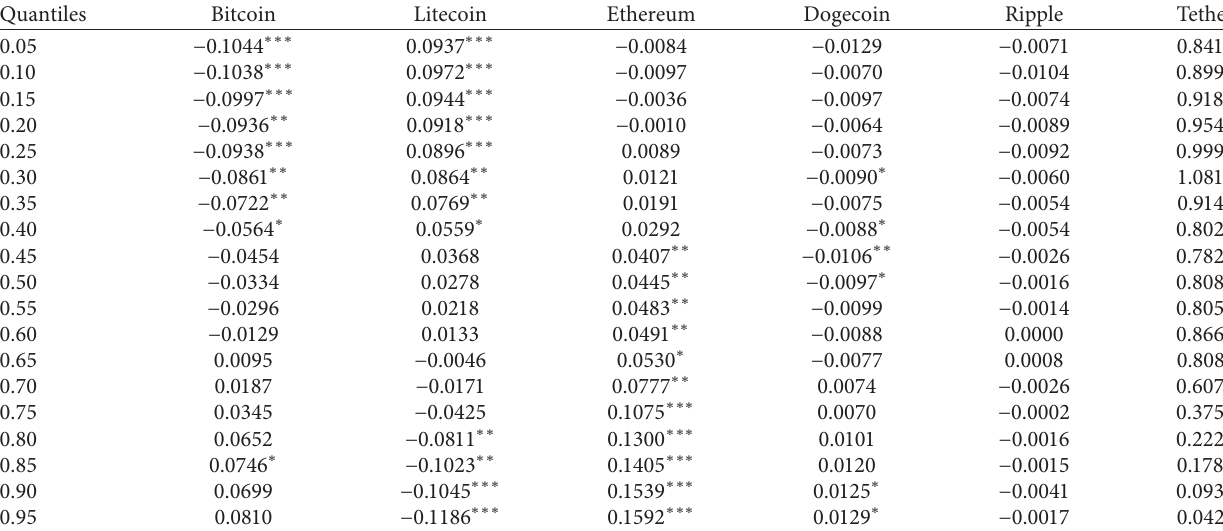
Table 7: Quantile regression results of